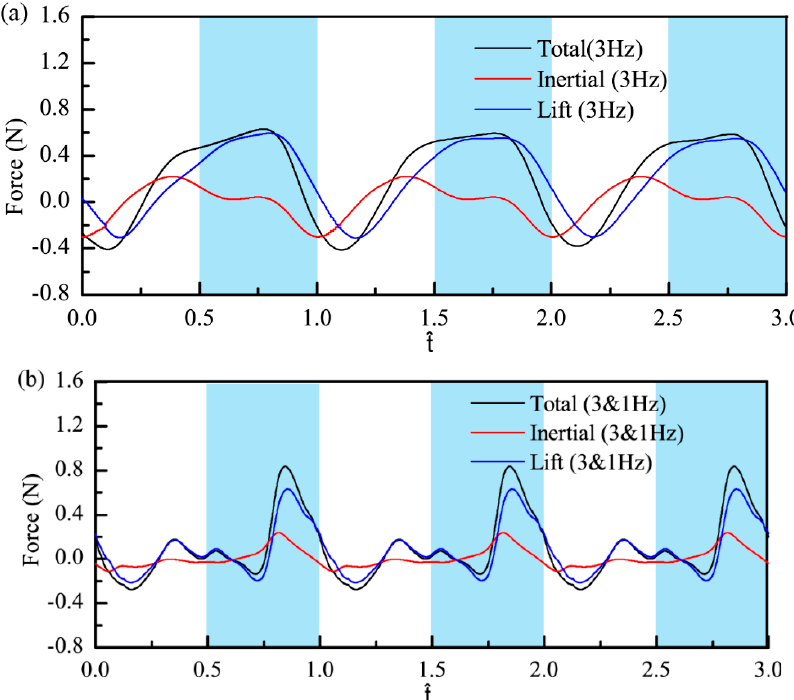
Figure 12. Force measurement of the FWR model in ( a ) 3 Hz case; ( b ) 3&1 Hz case.